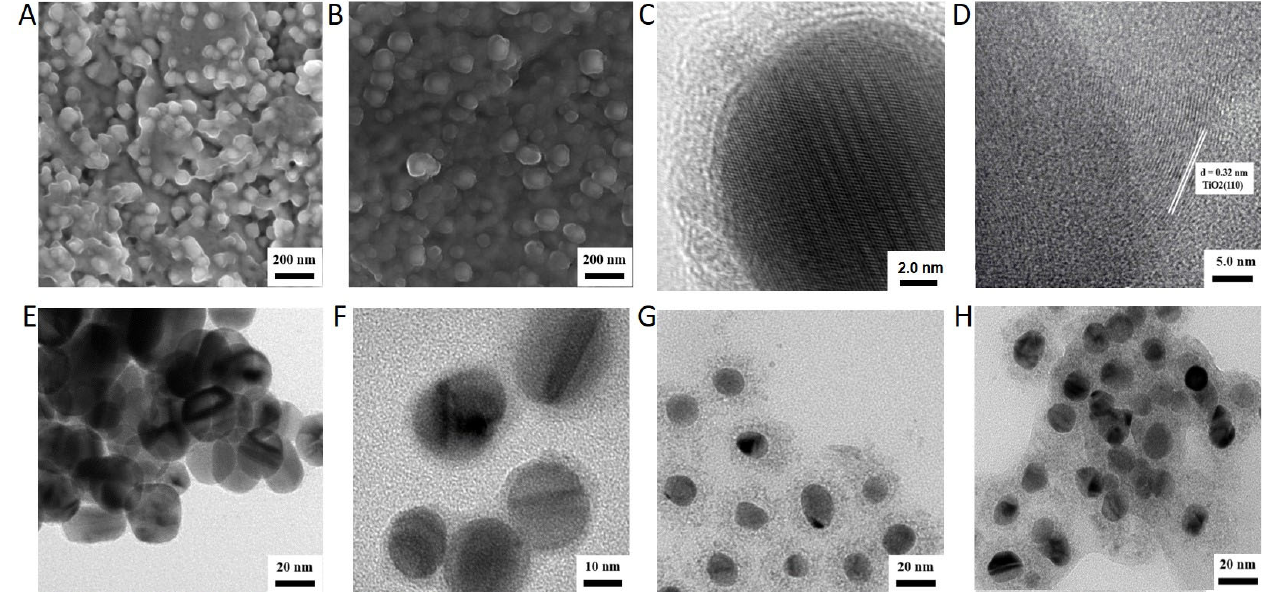
Figure 1. Transmission electron microscopy image of Ag ‐ modified TiO 2 . ( A ) Transmission electron microscopy image of TiO 2 ; ( B ) Transmission electron microscopy image of Ag ‐ doped TiO 2 ; ( C ) Transmission electron microscopy image of Ag ‐ core TiO 2 with a high resolution before the calcina ‐ tion treatment; ( D ) The crystal lattice structure of TiO 2 in Ag ‐ core TiO 2 observed using transmission electron microscopy image with a high resolution after the calcination treatment; ( E ) Transmission electron microscopy image of Ag; ( F ) Transmission electron microscopy image of Ag ‐ core TiO 2 with 5 nm thick TiO 2 shell (sodium bicarbonate at 0.9 mL); ( G ) Transmission electron microscopy image of Ag ‐ core TiO 2 with 20 nm thick TiO 2 shell (sodium bicarbonate at 1.3 mL); ( H ) Transmission elec ‐ tron microscopy image of Ag ‐ core TiO 2 with shell of TiO 2 agglomerated (sodium bicarbonate at 1.5 mL).